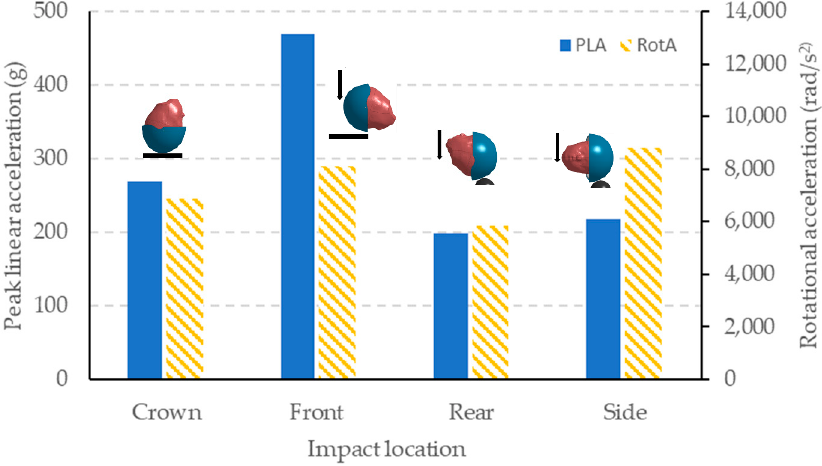
Figure 8. The peak linear (PLA) and the rotational accelerations (RotA) obtained from the DOT drop tests at four impact locations.